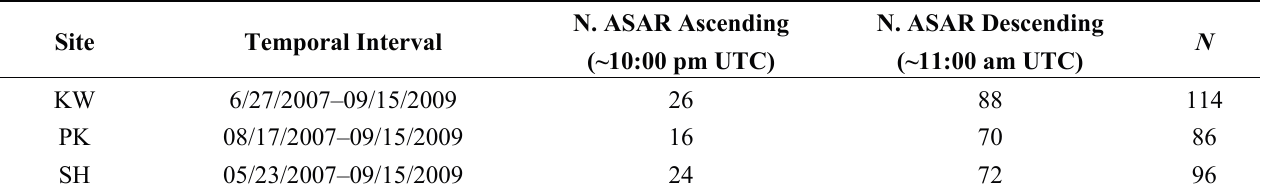
Table 2. Number of ascending and descending ASAR WS images temporally compatible with the ECV and in situ soil moisture (SM)